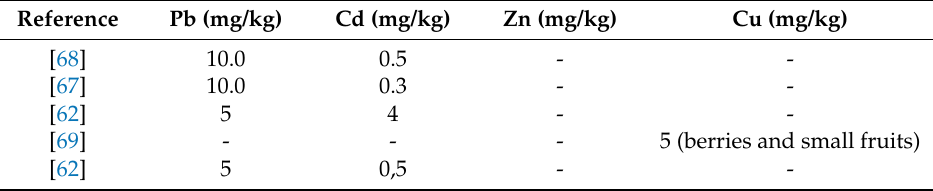
Table 6. Tolerable limits for heavy metals in food supplements and herbal